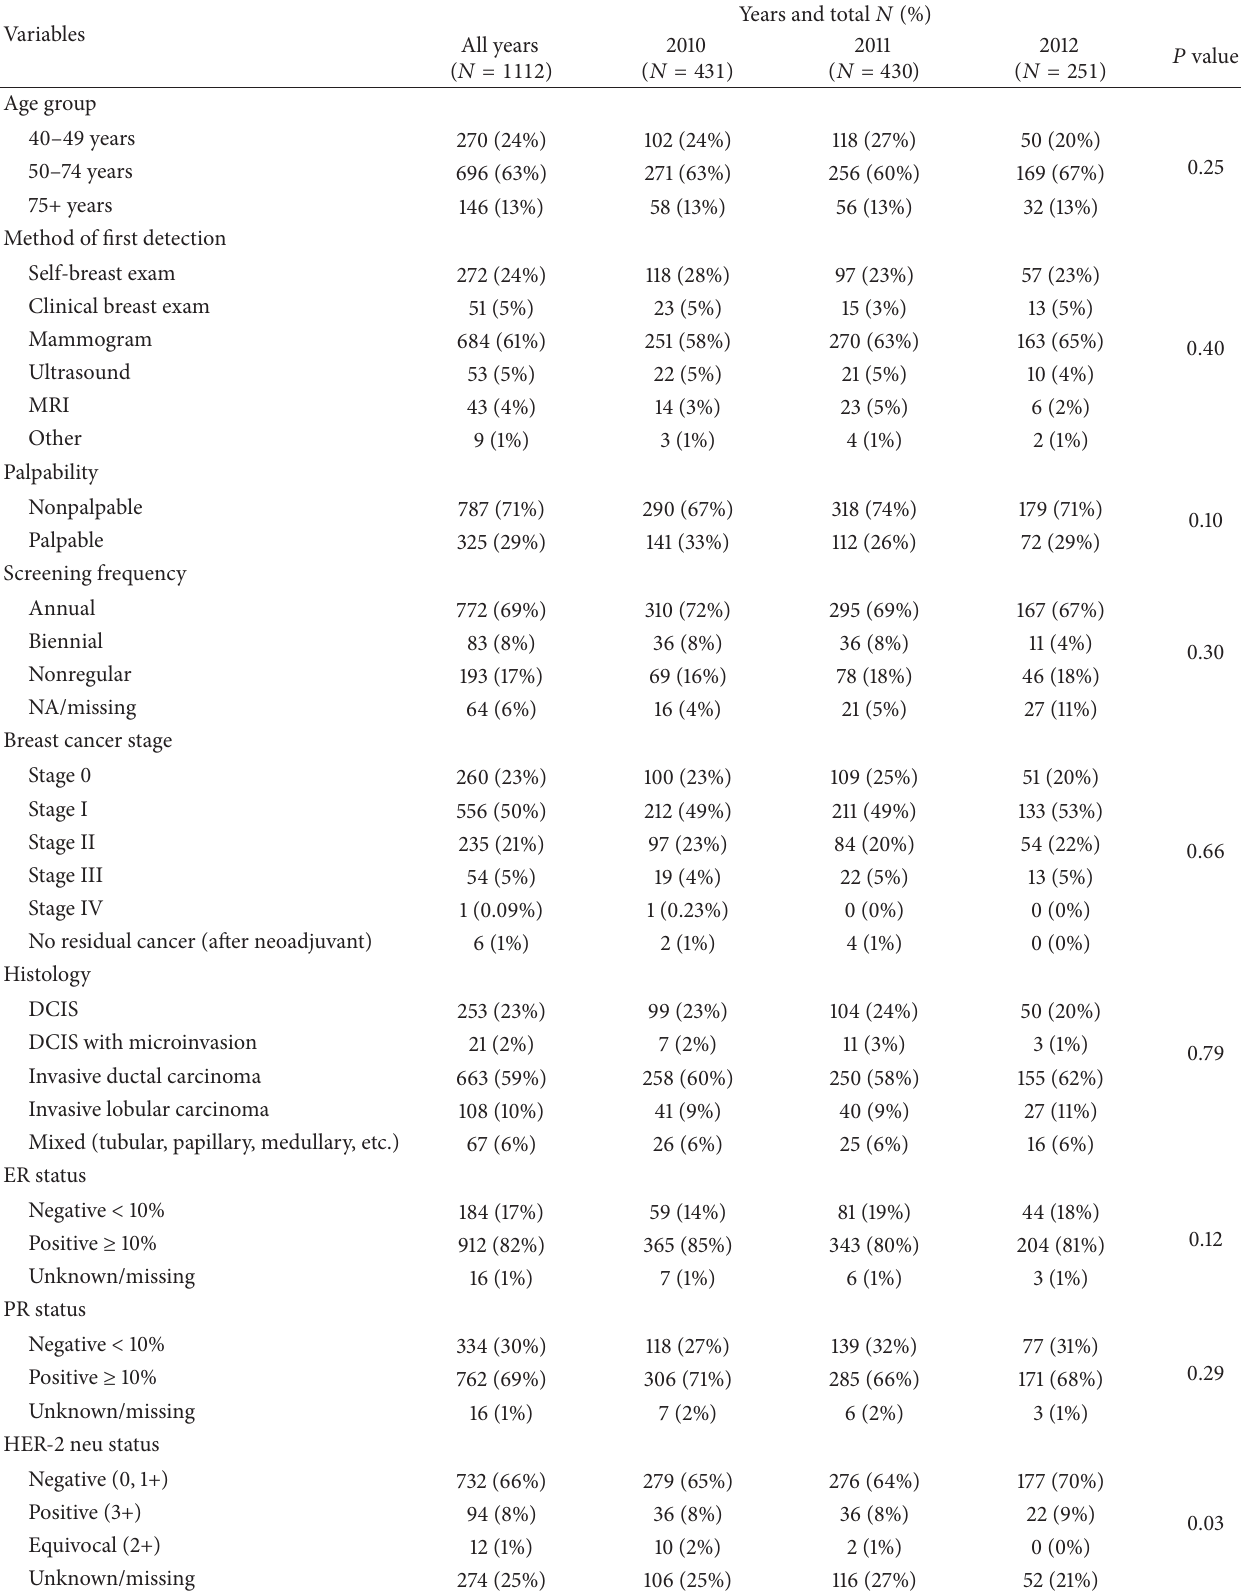
Table 1: Clinical characteristics between the years of 2010 and